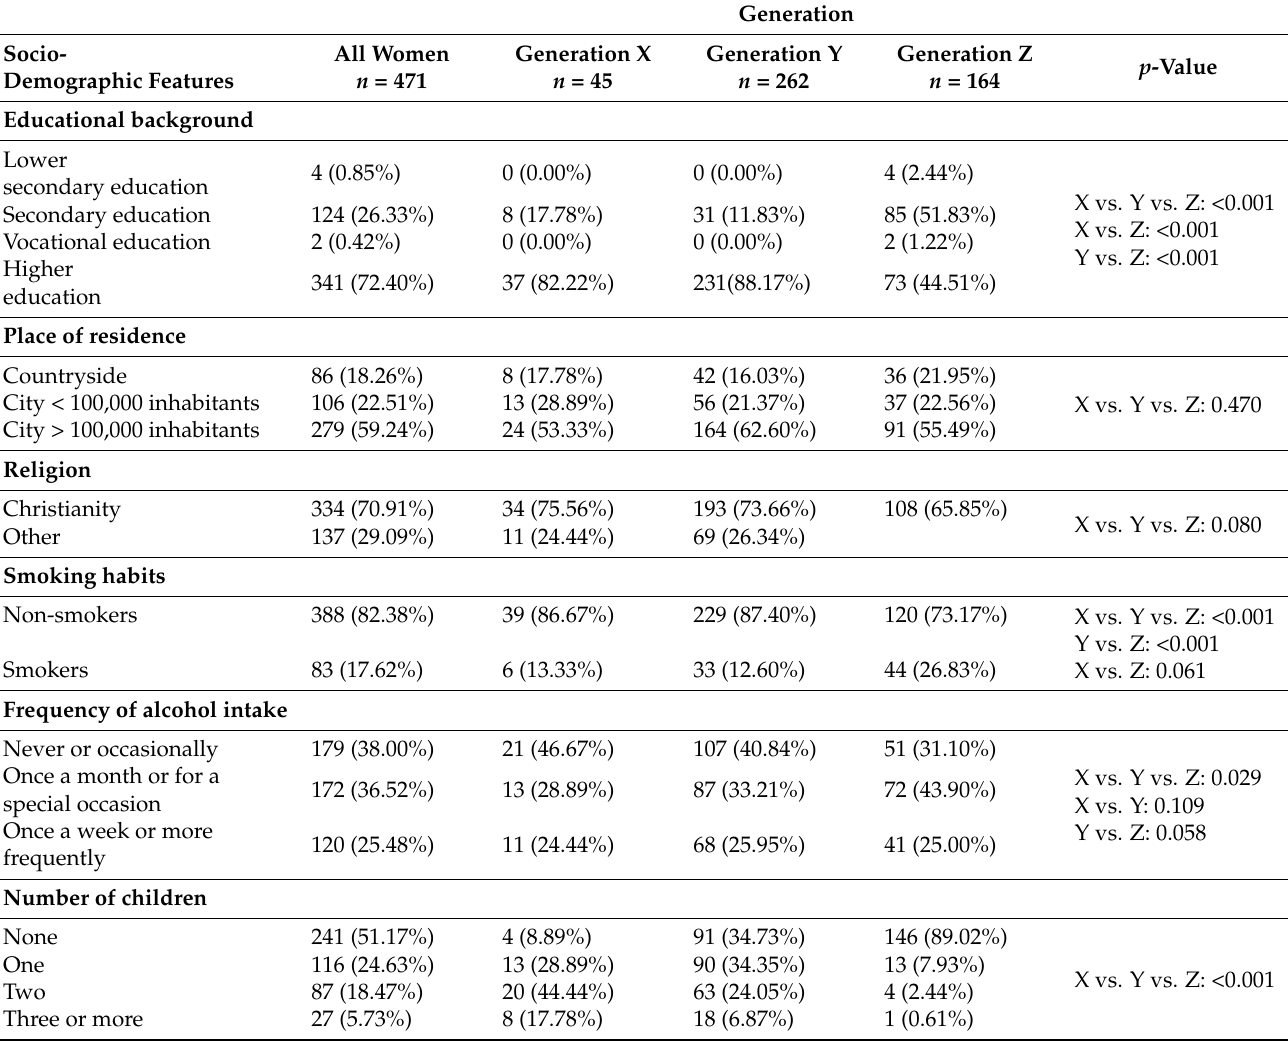
Table 3. Socio-demographic characteristics of the study